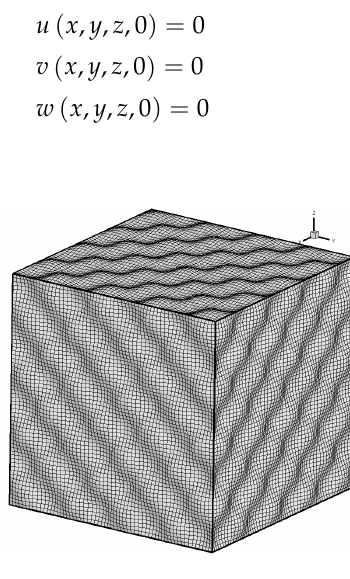
Figure 6. Wavy grid to test the metric cancellation errors in 3D sound